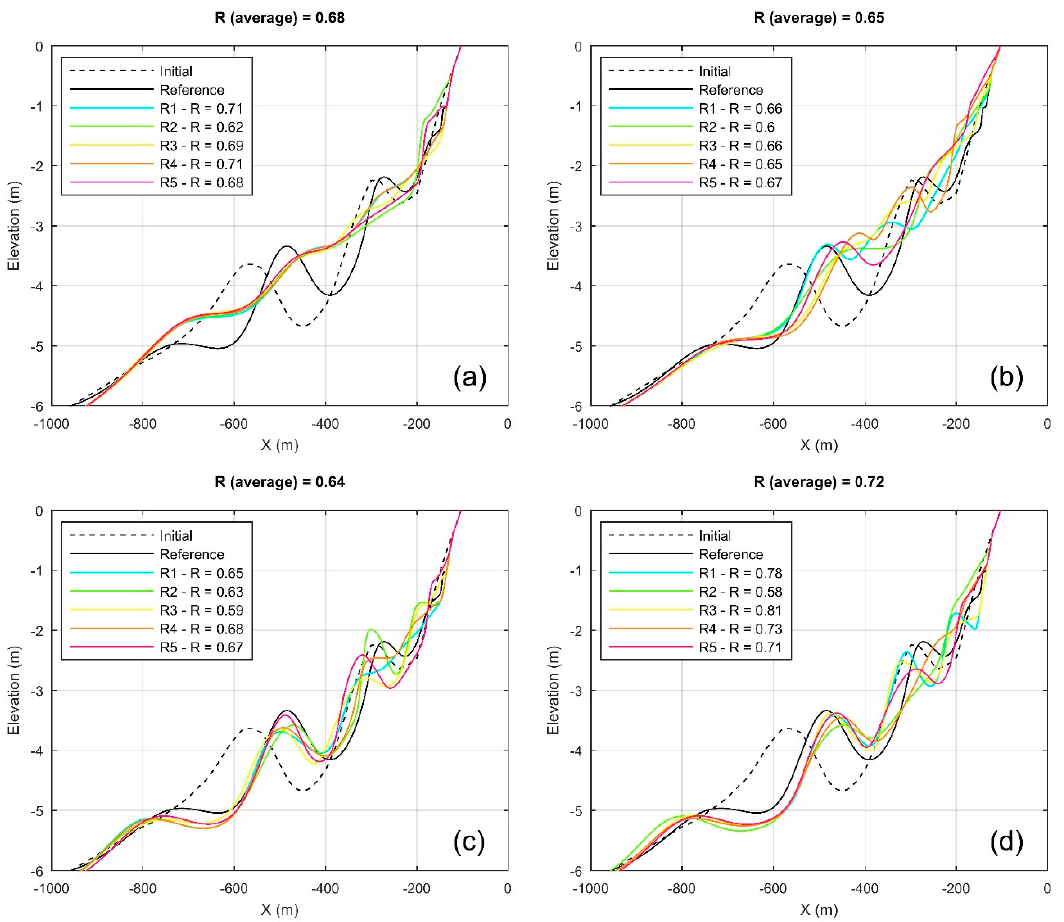
Figure 7. Initial and final profiles with the reduced wave climate of methods Fixed Bins method 3 (FBM3) ( a ), Fuzzy K-Means method 8 (FKM8) ( b ), Energy Flux method (EFM) ( c ), and Sediment Transport Bins method (STBM) ( d ) with k = 12 and T wc = 301 days. The black lines are the initial (dashed) and final (solid) profiles from the brute force model. The colored lines are the final profiles of each random sequence.